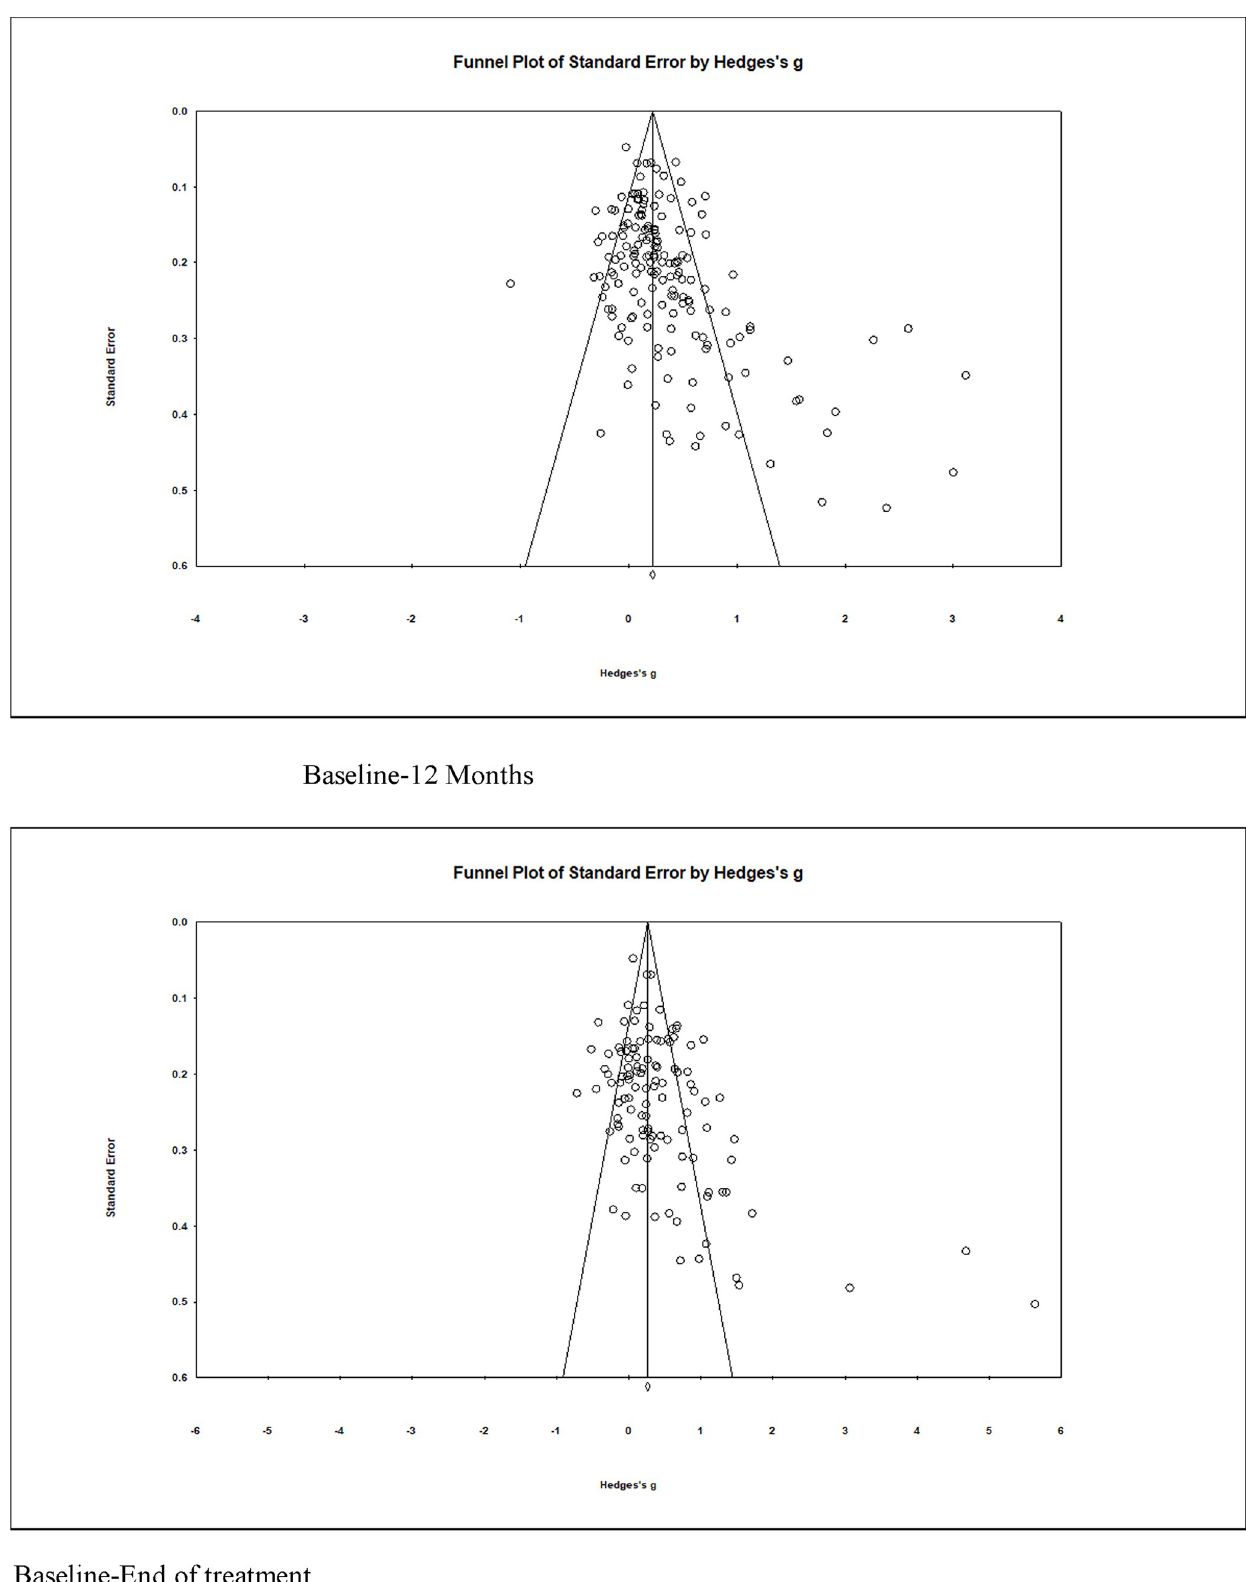
Fig 3. Funnel plots. https://doi.org/10.1371/journal.pone.0236525.g003 PLOS ONE | https://doi.org/10.1371/journal.pone.0236525 November16,